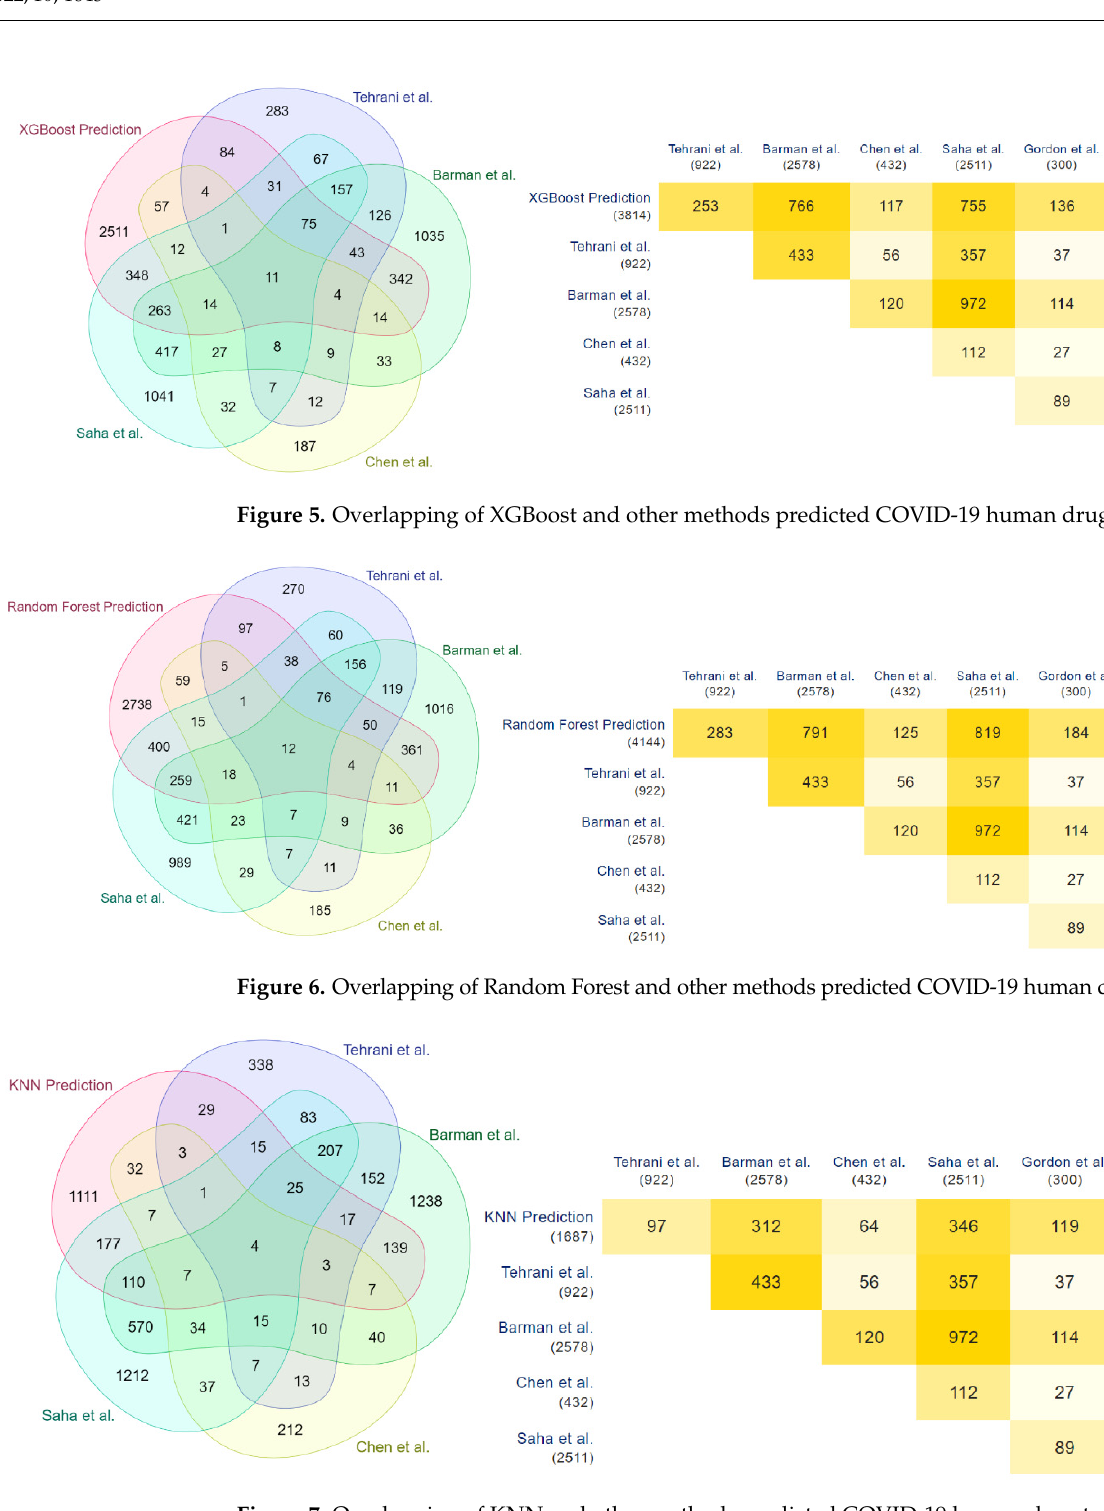
Figure 7. Overlapping of KNN and other methods predicted COVID-19 human drug targets.